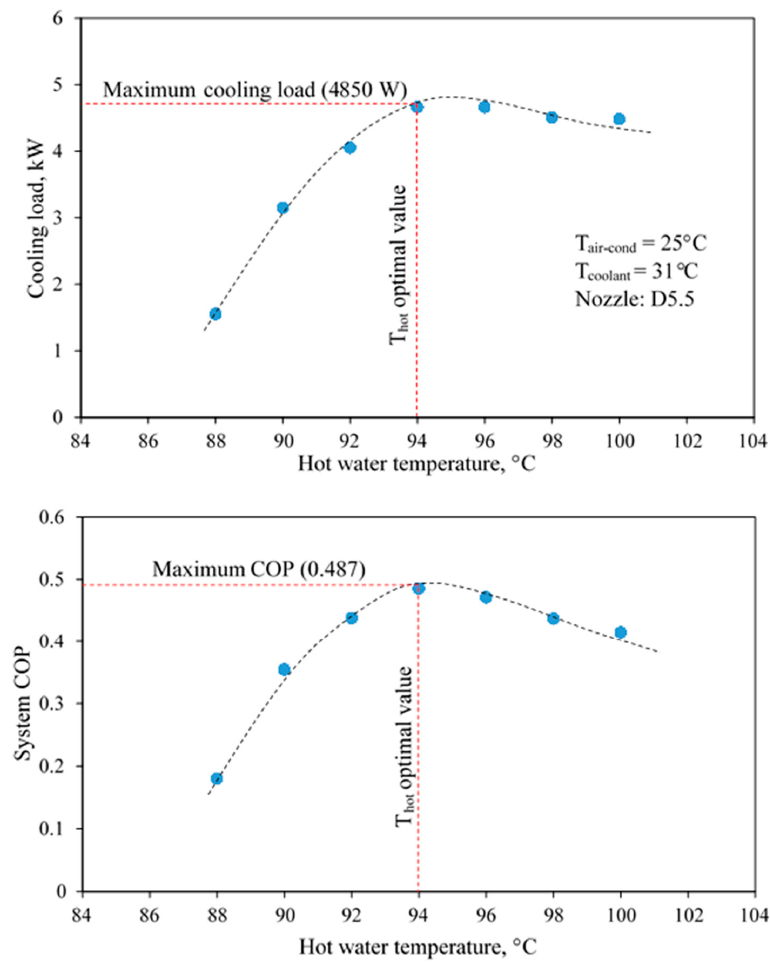
Figure 8. The cooling load and system COP against the hot water